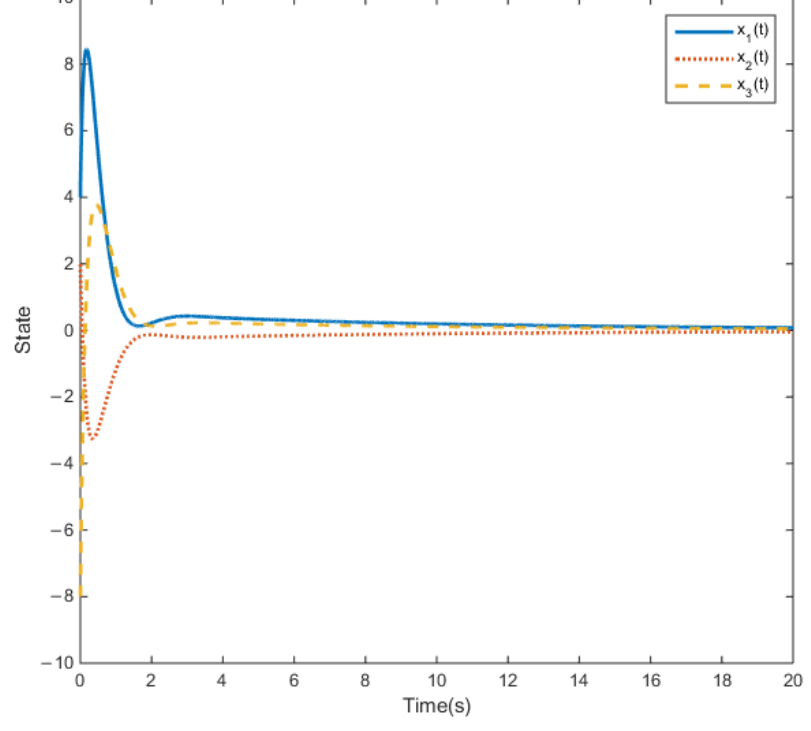
Figure 2. State response curves of System (9) in Example